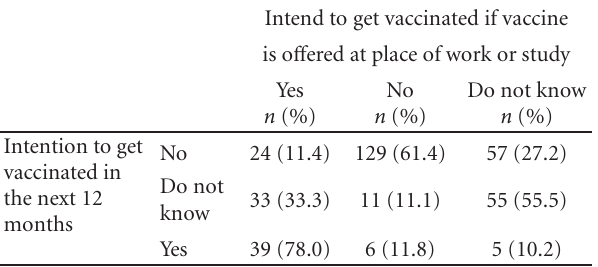
Table 4: Intention to get vaccinated if vaccine is o ff ered at place of work or